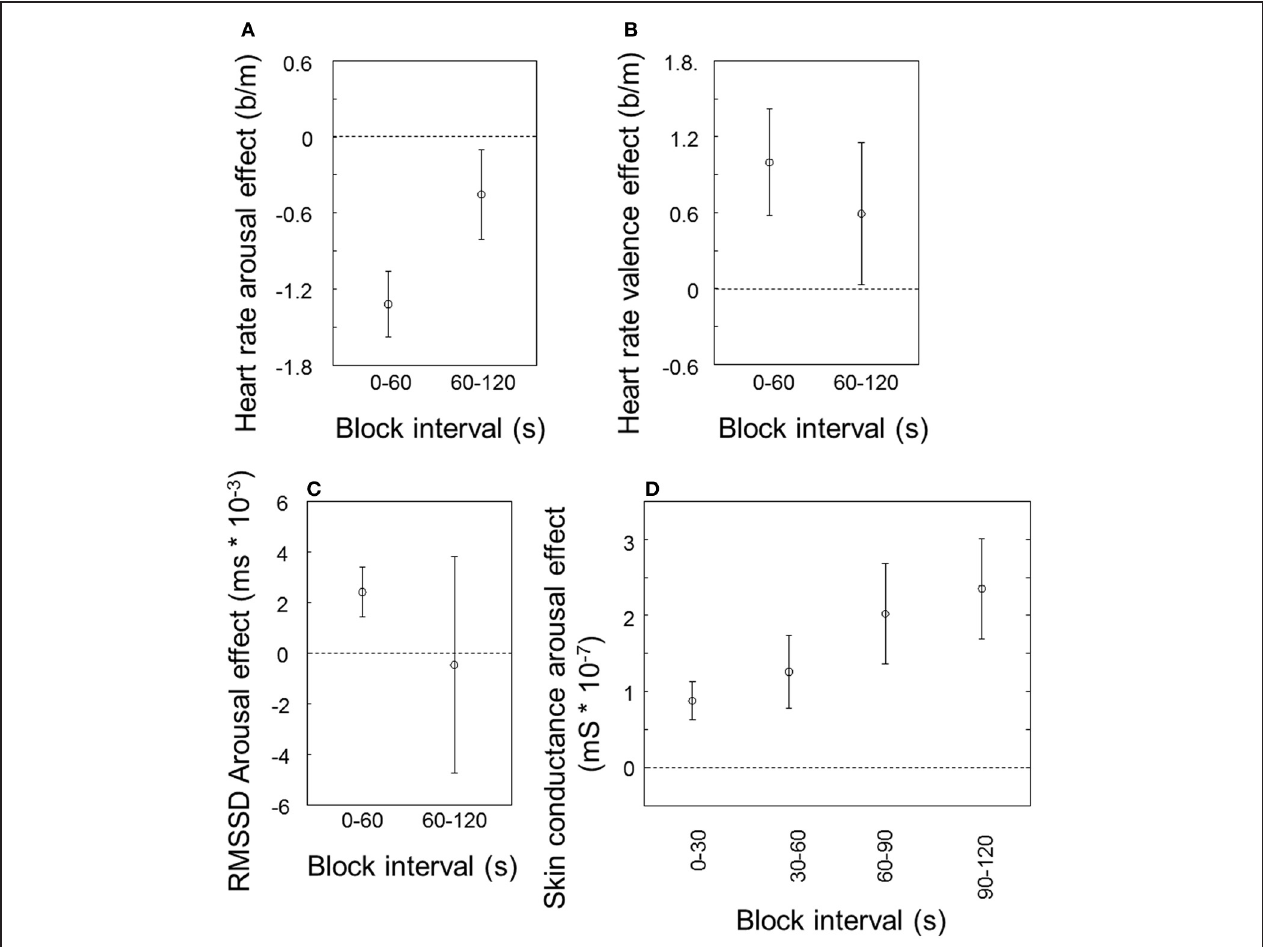
FIGURE 2 | Arousal and valence effects over time, averaged over modalities. Arousal effect on heart rate (A) , valence effect on heart rate (B) and arousal effect on heart rate variability (RMSSD) (C) , for the first and